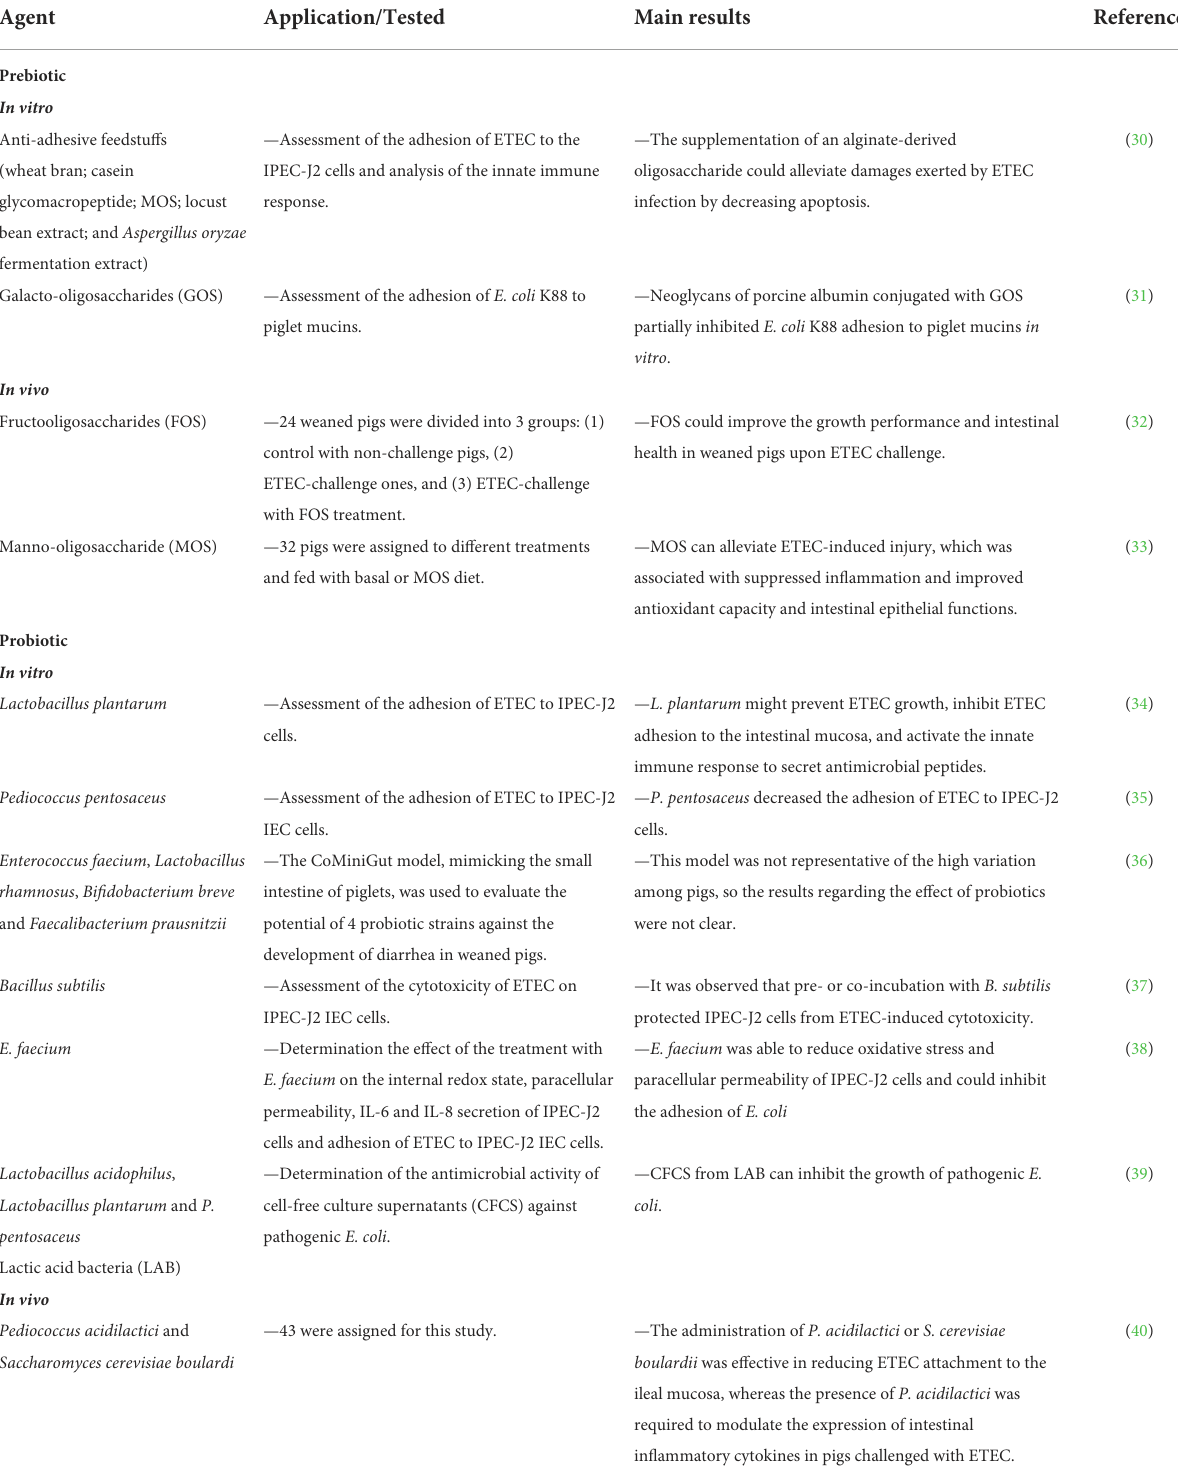
TABLE 1 Benefits and limitations of the major alternative agents for the control of post-weaning diarrhea (PWD) based on studies published since 2010. Agent Application/Tested Main